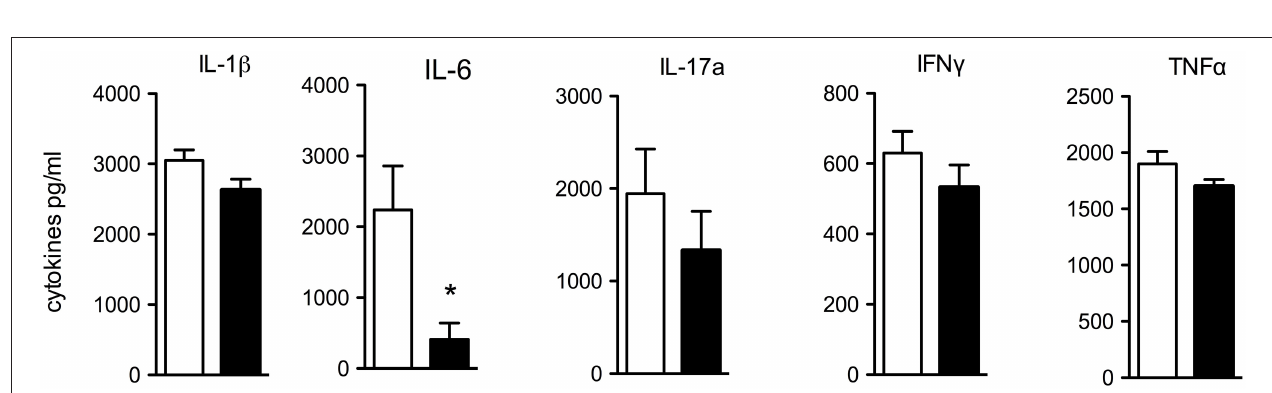
FIGURE 2 | Effect of transgene IL-37 on blood differentiation and cytokine release in whole blood cultures of IL-10KO mice during chronic colitis. (A) Heparinized blood samples were analyzed by automatic blood smear differentiation at the time of colon removal. (B) Heparinized mouse whole blood samples were stimulated with LPS (1 µ g/ml) or not. Cytokines were measured in supernatants after 24h by multiplex array or Elisa (IL-6). Data are expressed as the mean (SEM). Open squares: IL-10KO mice ( n = 10), closed squares: IL-10KO/IL-37tg mice ( n = 5). * p < 0.05, ** p < 0.01, *** p < 0.001, **** p < 0.0001. Statistical significance tested with Mann-Whitney-Test.